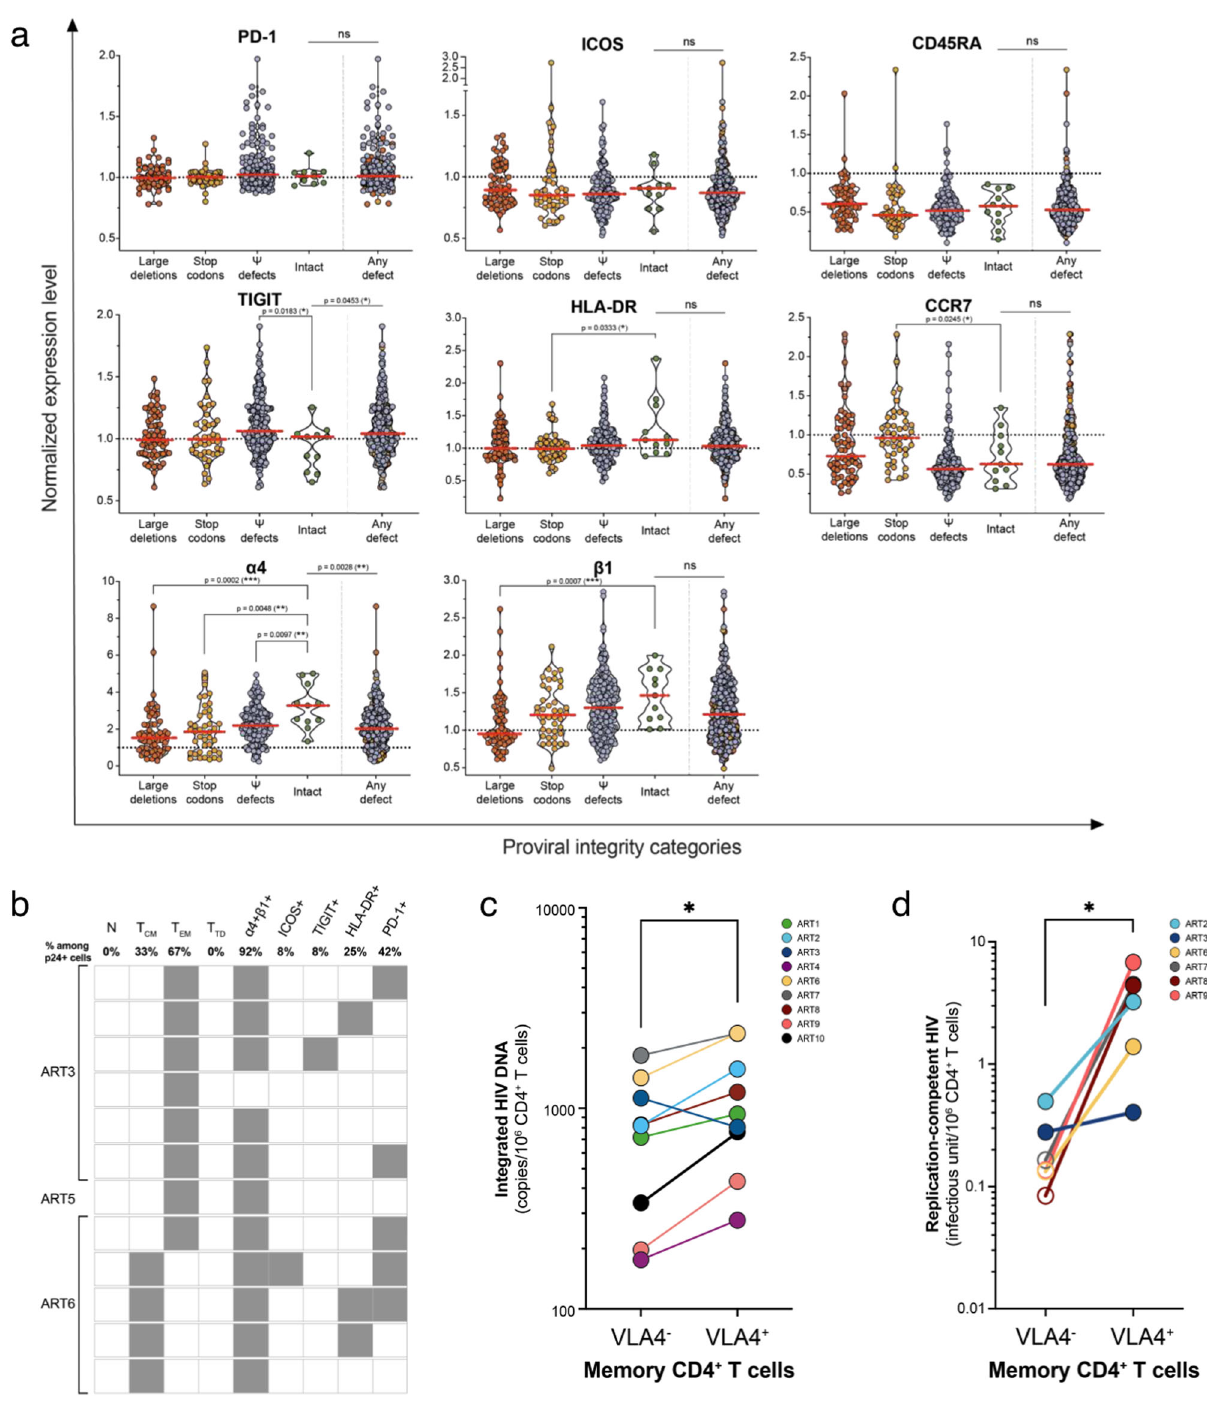
Fig. 6 | Phenotype of cells harboring inducible, translation- and replication- competent proviruses. a Normalized expression levels of PD-1, ICOS, CD45RA, TIGIT, HLA-DR, CCR7, α 4, and β 1 on cells harboring HIV genomes with different types of genetic defects. Each dot corresponds to a single cell, and cells are groupedaccording to the geneticdefects found in the viral genomesthey carry. In each panel, the violin plot on the right includes all defective proviruses grouped together. Two-tailed Mann-Whitney unpaired nonparametric t-tests were per- formed to assess differencesinthe expressionlevel of each marker between intact proviruses and all other categories (* p <0.05; ** p <0.01; *** p <0.001). In all panels, the threshold ratio of 1 is indicated by a dotted line and the medians of the violin plotsarerepresentedbyredlines. b Phenotypicanalysisofthep24+cellsharboring intact HIV genomes. Grey square denotes the expression of a given marker.